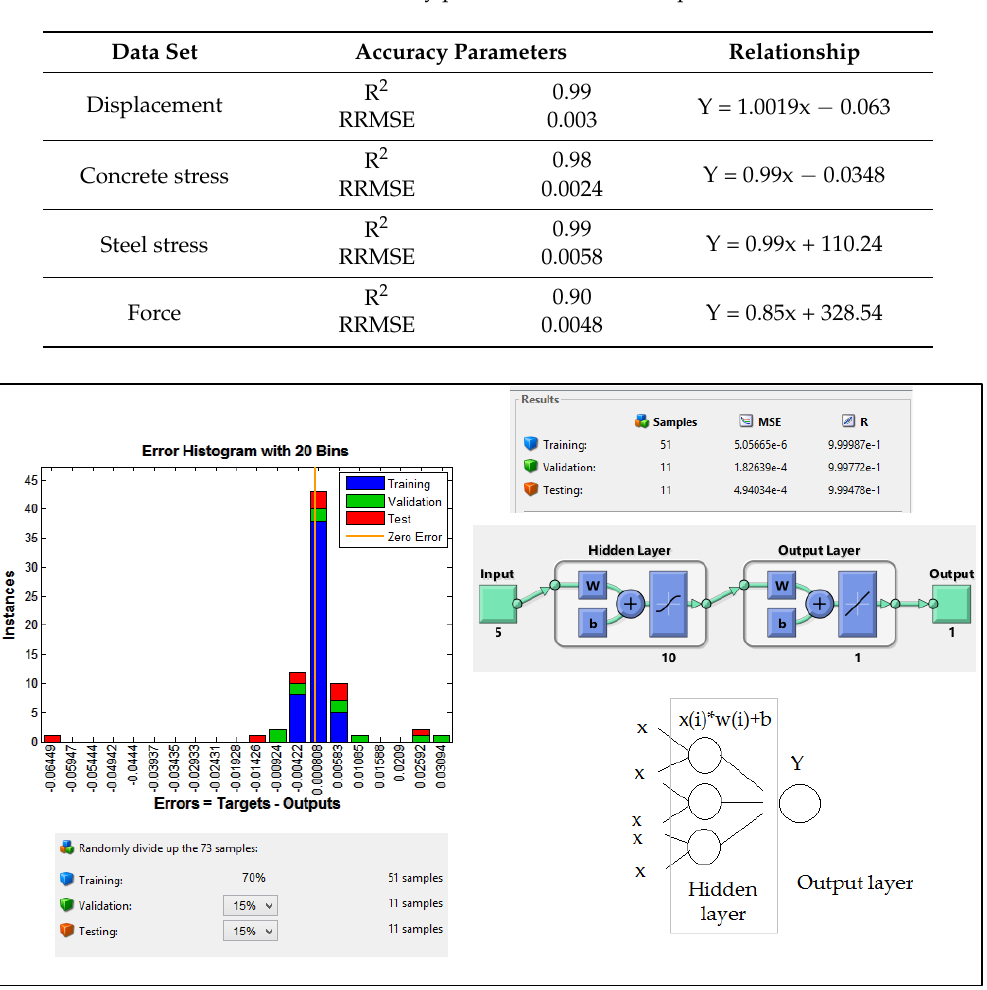
Figure 36. Neural network result for force.